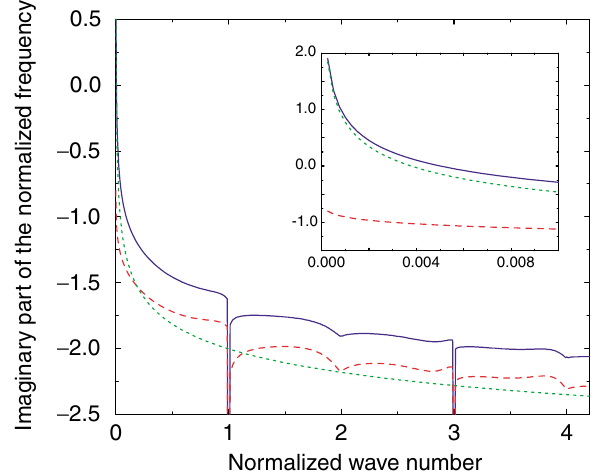
FIG. 1. (Color) The imaginary part of the normalized fre- quency (cid:12) as a function of the normalized wave number k=k for the NLC main damping ring [16], where k wiggler fundamental radiation wave number defined in Eq. (14). The solid curve includes the entire CSR impedance while the dotted and dashed curves include either the steady state dipole CSR impedance or the wiggler CSR impedance, respectively. The inset shows a blowup of the low frequency region where the beam is unstable.